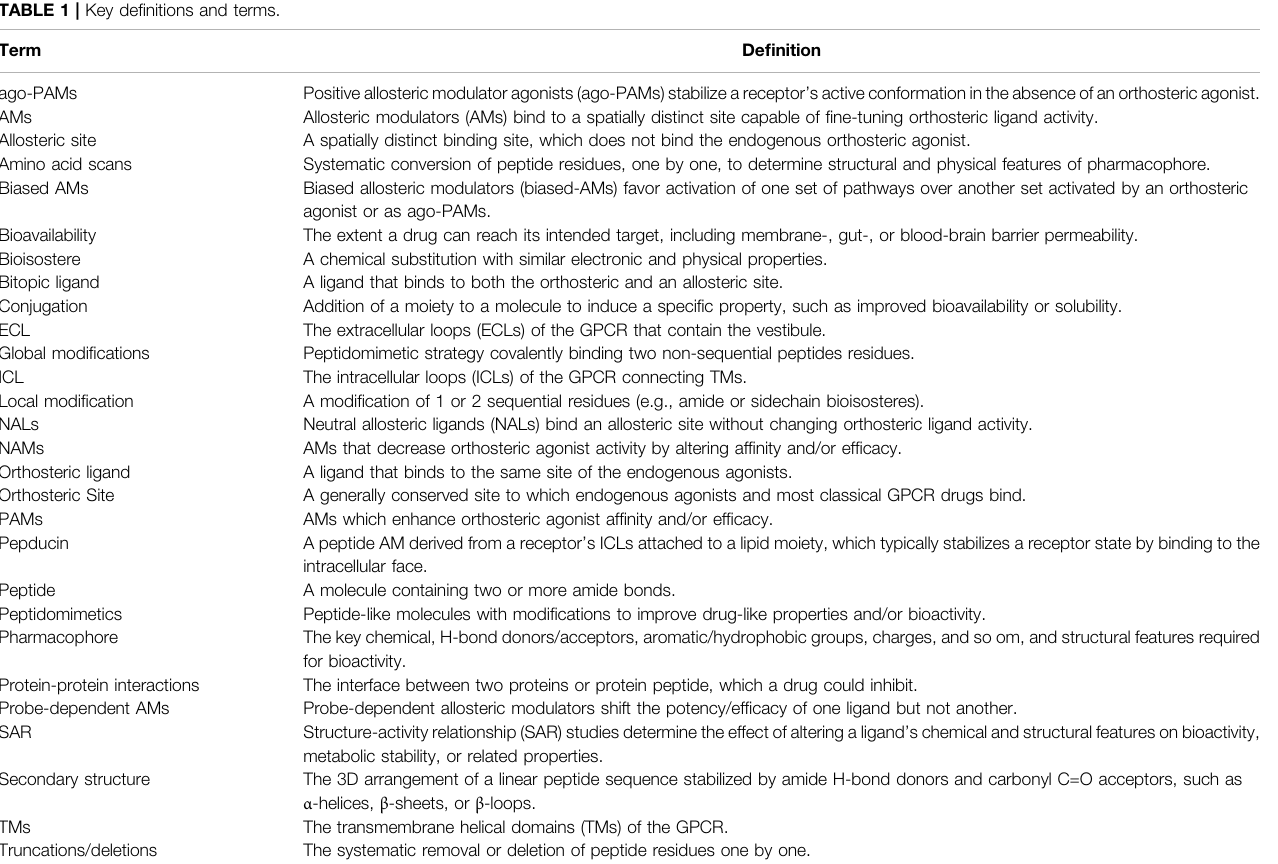
TABLE 1 | Key de fi nitions and